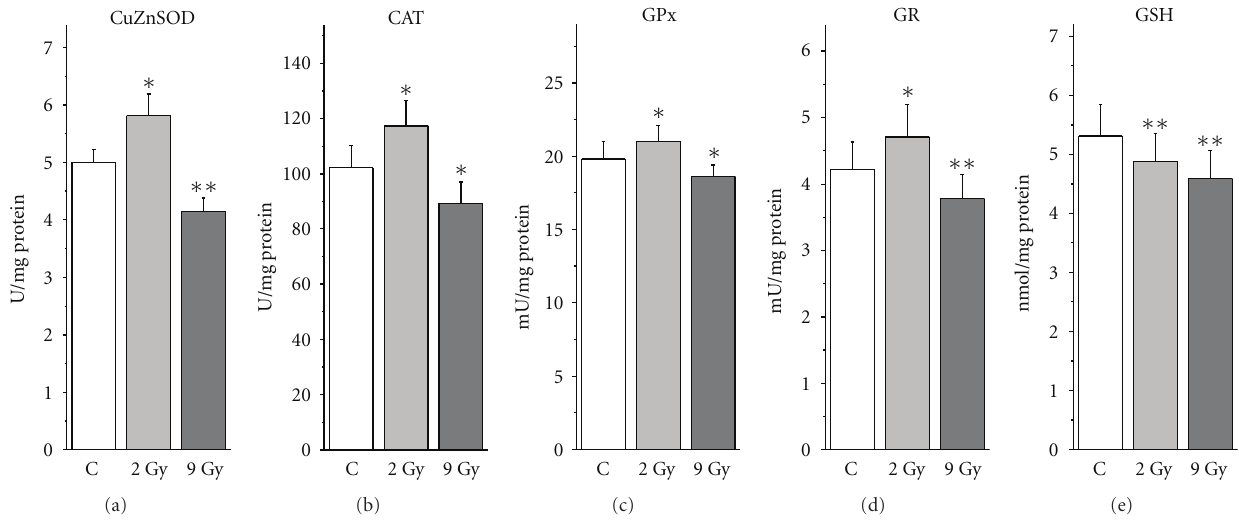
Figure 1: AO enzyme activities and concentration of GSH in blood cells nonirradiated (C) and irradiated with 2Gy and 9 Gy of γ -radiation, in healthy women younger than 45 years. The data are given in mean values ± SEM; ∗ P < 0 . 05, ∗∗ P < 0 . 01 in comparison to C (student’s paired t -test).